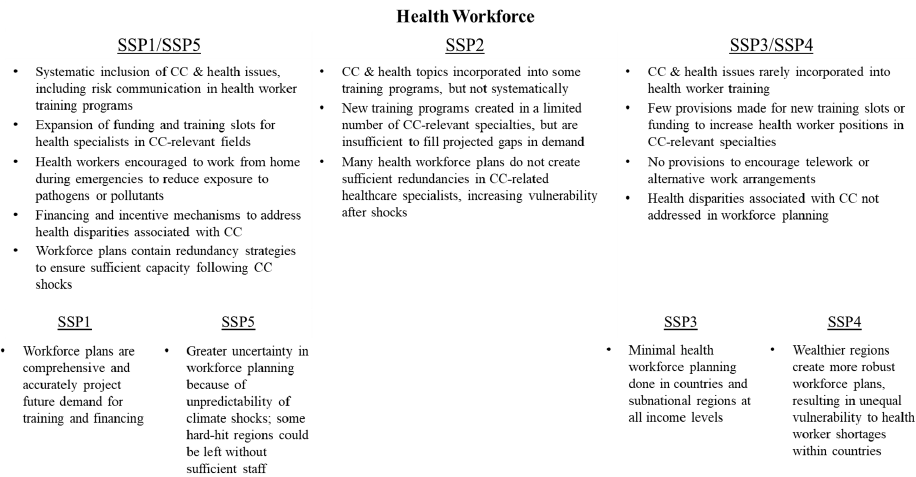
Figure 4. Variation in health workforce conditions across SSPs.